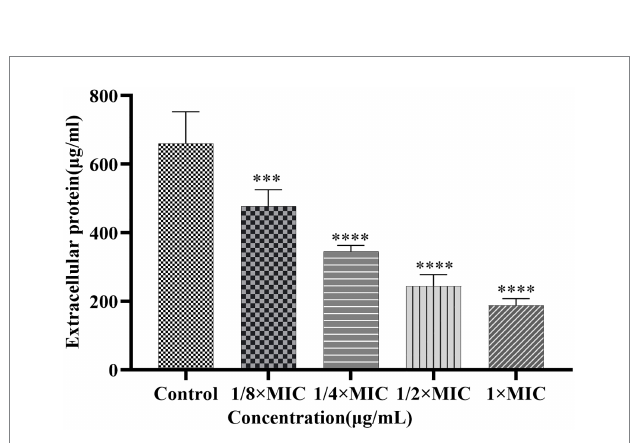
FIGURE 8 Effect of Disaspidin BB on the biofilm extracellular protein of SEP-05. *** means p < 0.001. **** means p < 0.0001.